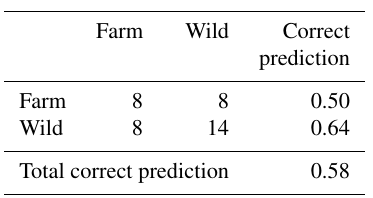
Table 2. Confusion matrix of fish origin classification by QDA (sample origin rows, predicted origin columns).